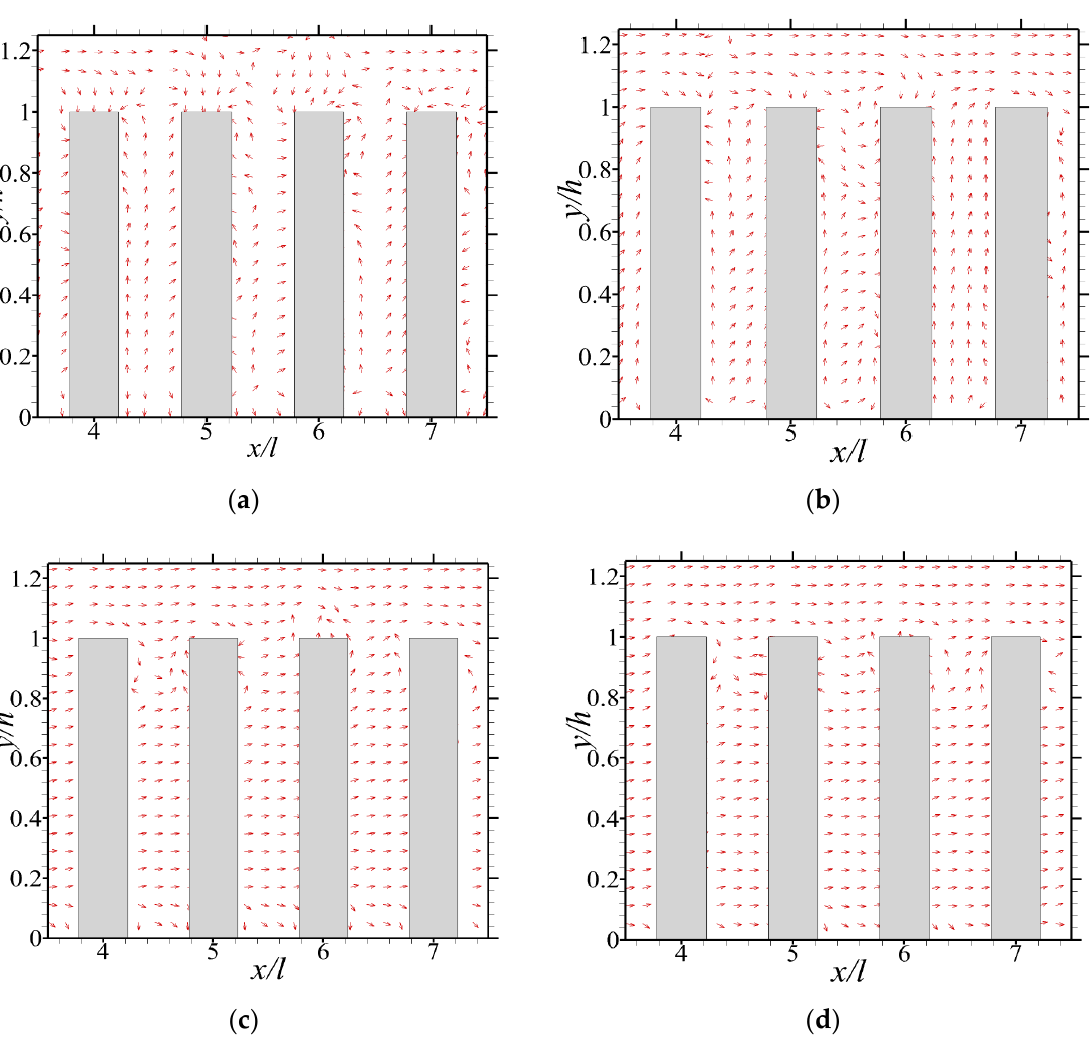
Figure 4. Vector plots for the selected rods at ( a ) z = 0 in Test A ; ( b ) z = 0 in Test B ; ( c ) z = l in Test B ; ( d ) z = − l in Test B. Note that for each plot, gray-filled boxes indicate locations of porous medium rods. Vectors have also been skipped to maintain clarity.